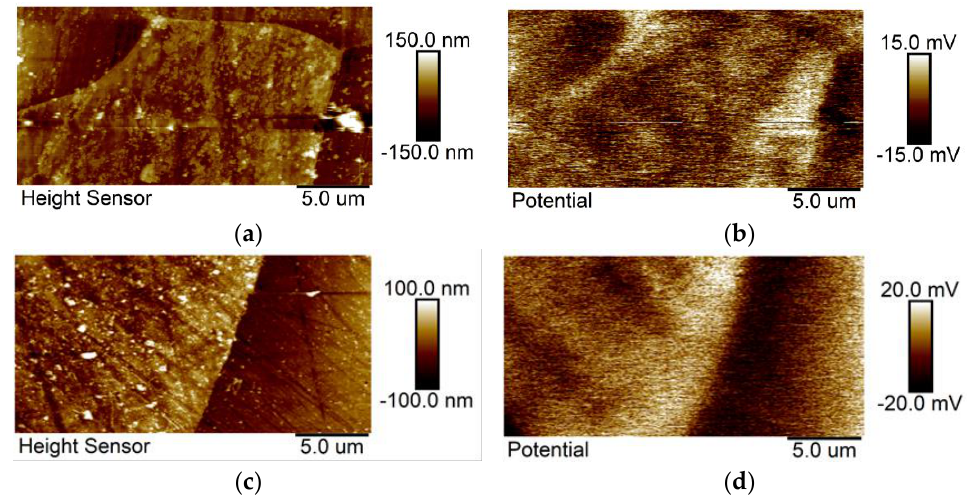
Figure 11. AM-KPFM analysis of the steels with the topography and the corresponding Volta potential map, respectively. Steel 200 ( a , b ); 300 ( c , d ).